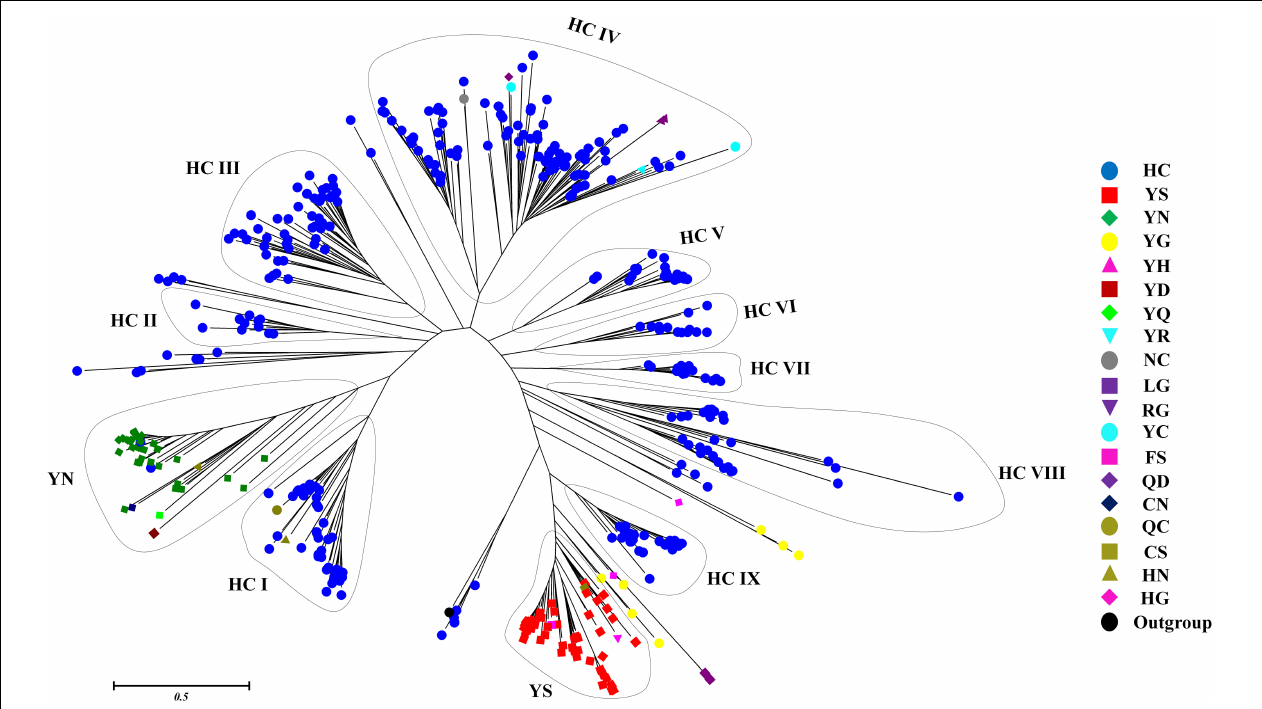
FIGURE 4 | Phylogenetic relationship of putative cyanobacterial orthocaspases (OCAs). The rooted tree of only the Peptidase C14 domain of all the putative OCAs was constructed using the neighbor-joining method with the metacaspase-like protein of Thalassiosira pseudonana CCMP1335 (XP_002295354.1) as the outgroup. The optimal tree has the sum of branch length = 89.299. The tree is drawn to scale, with branch lengths in the same units as those of the evolutionary distances. The evolutionary distances were computed using the JTT matrix-based method and are in the units of the number of amino acid substitutions per site. The analysis involved 474 (473 cyanobacterial Peptidase C14 domain + 1 outgroup) sequences. All positions containing gaps and missing data were eliminated. Distinct clades are assigned based on the active site motifs in majority of the Peptidase C14 sequences. Eleven distinct clades were identified where HC catalytic dyads containing Peptidase C14 sequences formed nine whereas YS and YN catalytic motifs containing Peptidase C14 sequences formed two respective clades. Peptidase sequences with other substitution at catalytic motifs are scattered along the